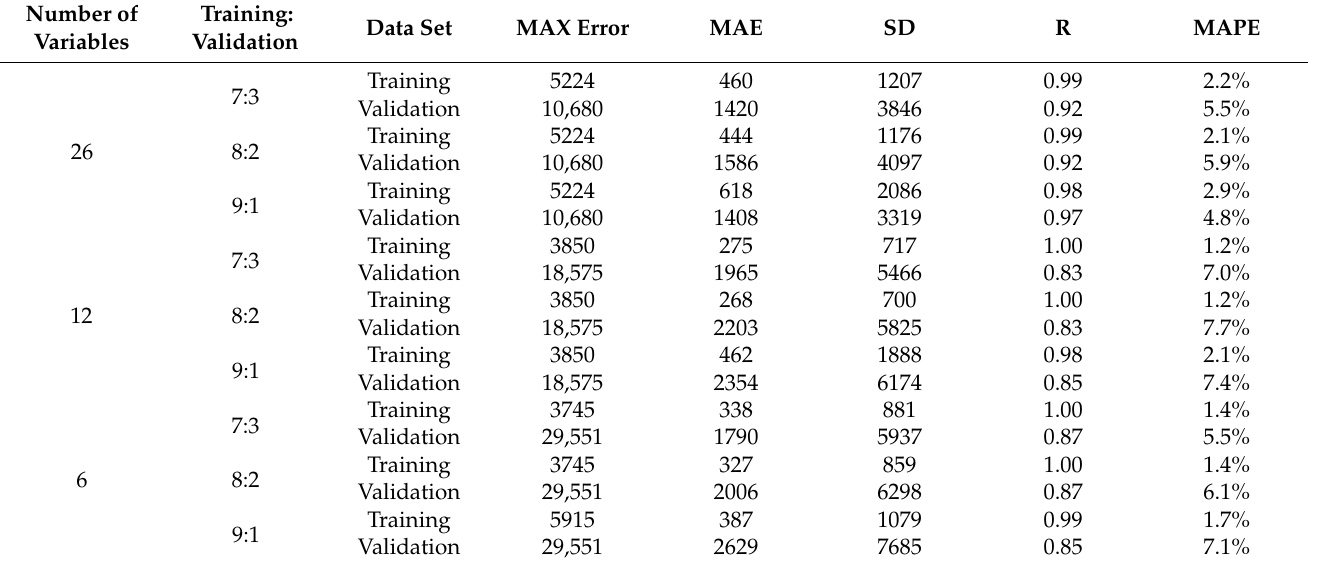
Table A6. Analysis of the results of the CART model for electricity consumption.